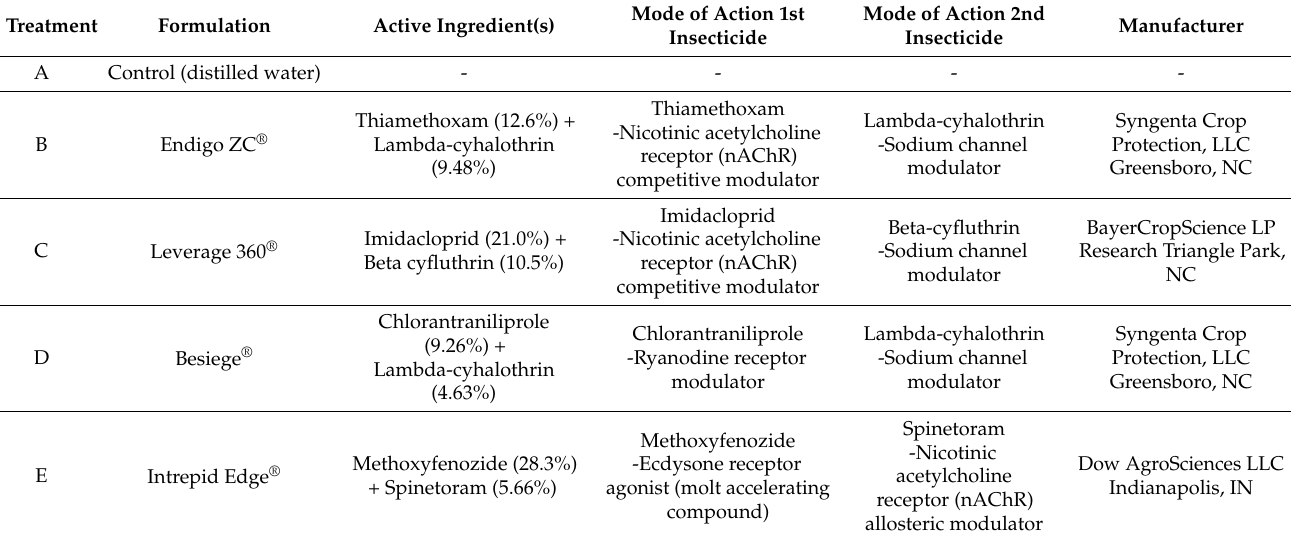
Table 1. Active ingredients and modes of action of formulated premix insecticides assessed for acute whole-body contact toxicity to adult male (Experiment 1) and female (Experiment 2) Osmia lignaria .